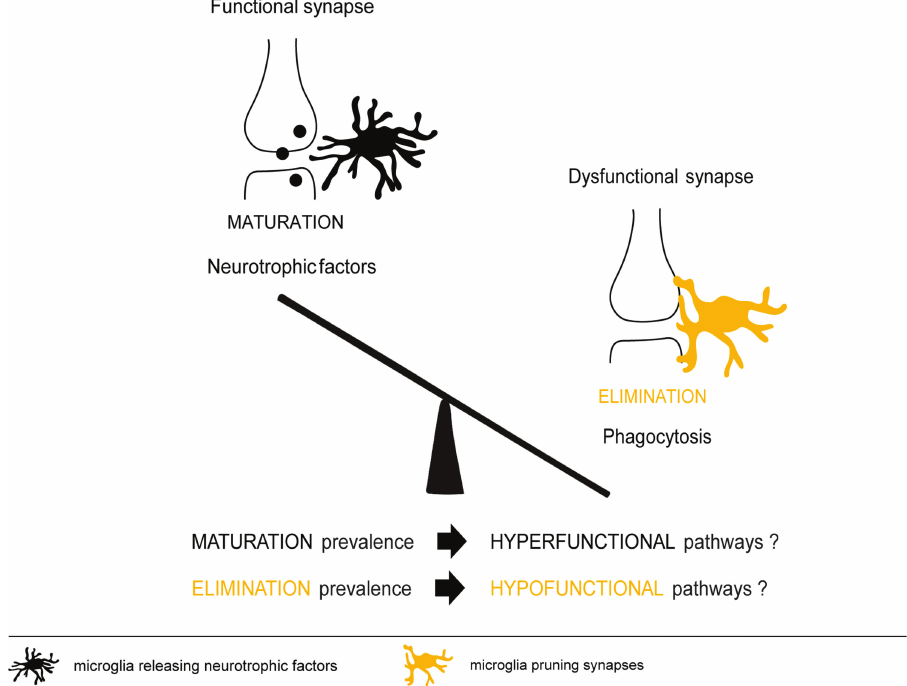
Fig. 4 Putative mechanisms by which microglia may contribute for the establishment of dual dopaminergic pathways. Schematic representation of novel putative mechanisms by which microglia may oppositely in fl uence dual dopaminergic pathways: imbalance between the ability to eliminate and strengthen